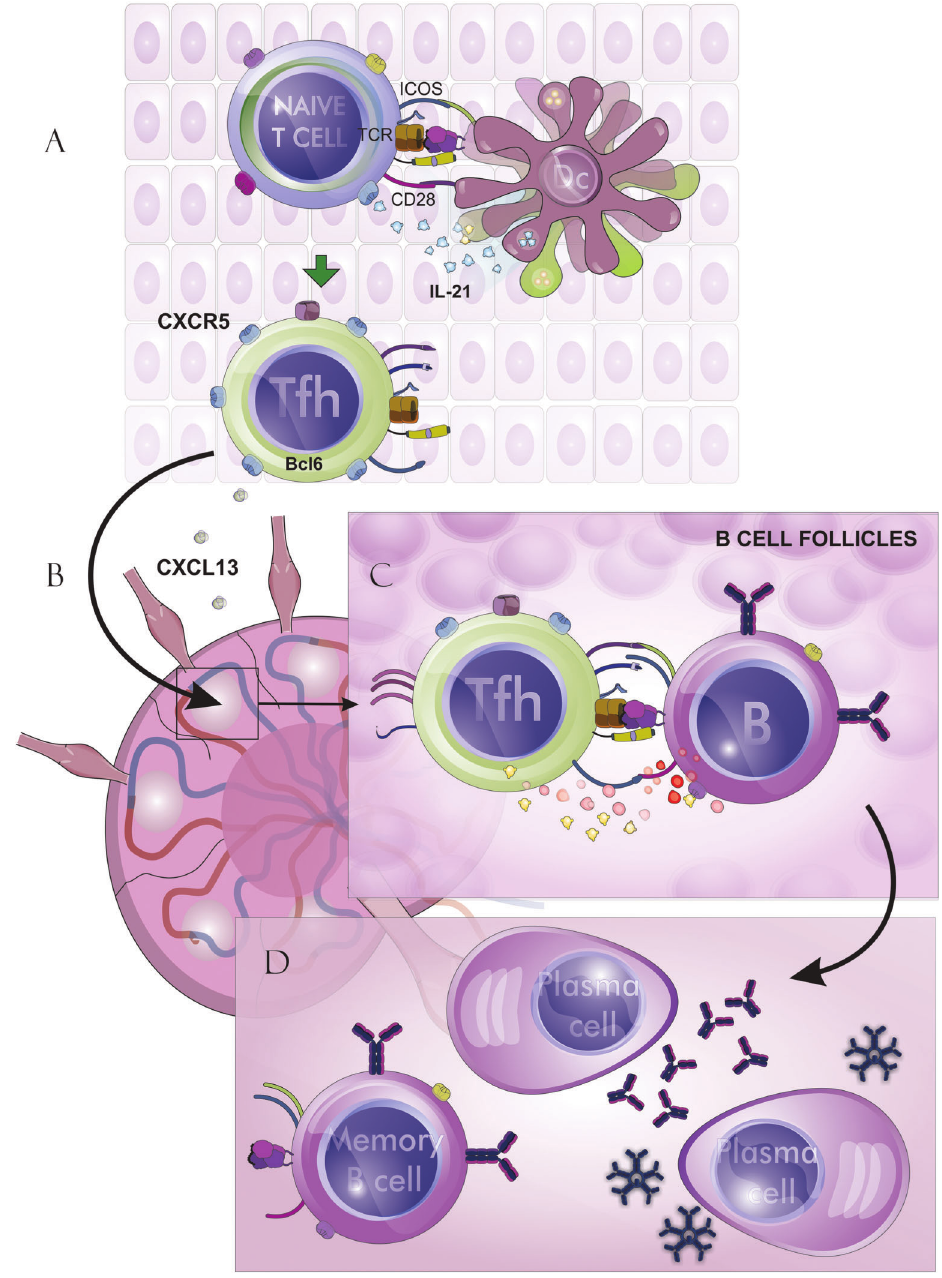
Figure 2. Schematic view of dentritic cell (DC) participation in the naive CD4 + T cells differentiation into follicular helper T cells (Tfh) lineage by means of an increase in Bcl-6 expression and downregulation of its antagonist Blimp-1 under the in fl uence of a combination of elements, including IL-21, inducible co-stimulator (ICOS), T cell receptor (TCR) and likely CD28 ( A ). Since T cells are primed during interaction with DC in the T cell zone and B cells reside in the B cell follicle, antigen-speci fi c T cells and their cognate B cells must migrate towards a secondary lymphoid organ to meet each other and promote the generation of germinal centers by differentiation of primed B cells ( B